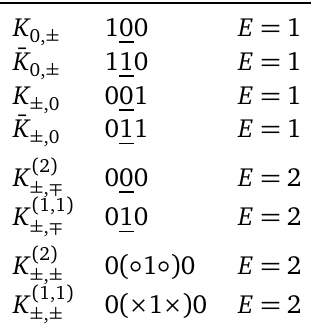
Table 1: Elementary (anti-)kinks and some of the kink-(anti-)kink states in the extreme stag- gering limit of the M 2